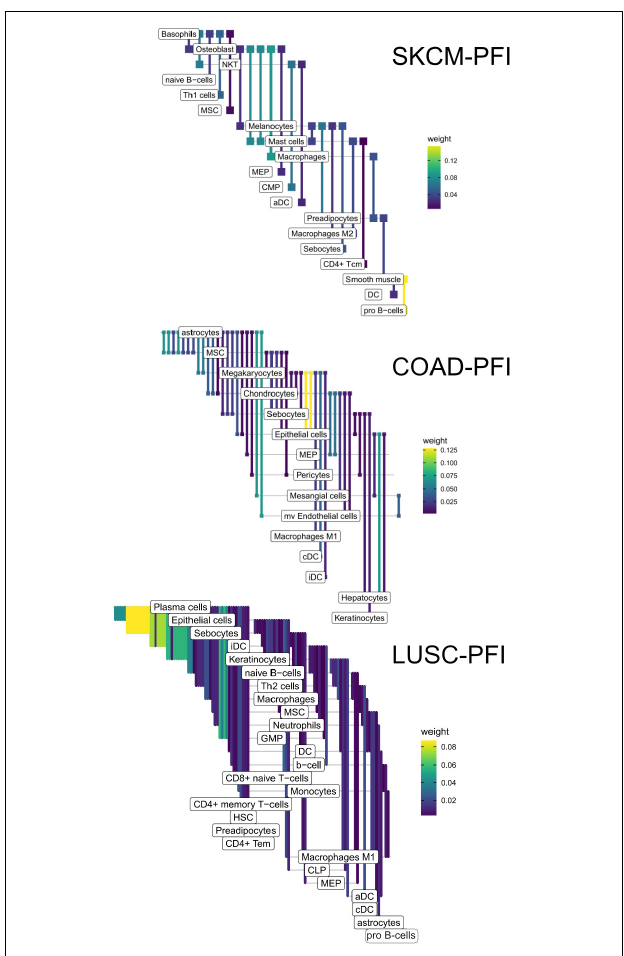
FIGURE 9 | Informative edges selected by XGBoost models for prediction within study. Color indicates information gain.